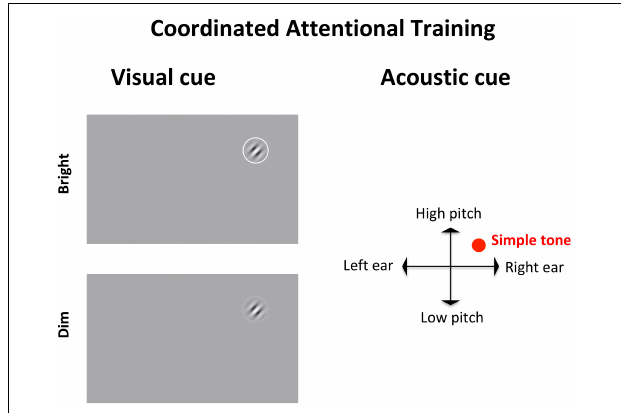
The training regime was composed by 10 daily sessions of 500 trials. In both types of training, contrast and spatial